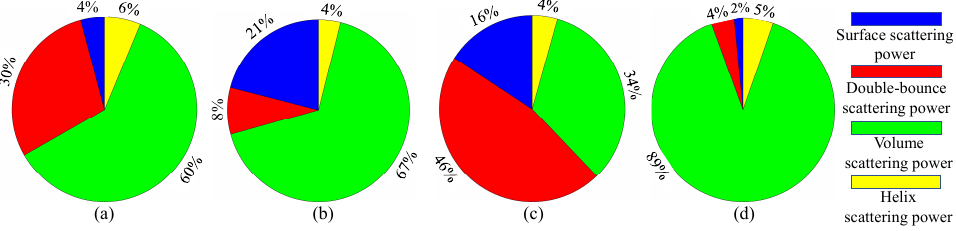
Figure 15. Illustration of scattering mechanism in different regions. ( a ) High-density urban. ( b ) Vege- tation. ( c ) Developed urban. ( d ) Low-density urban.